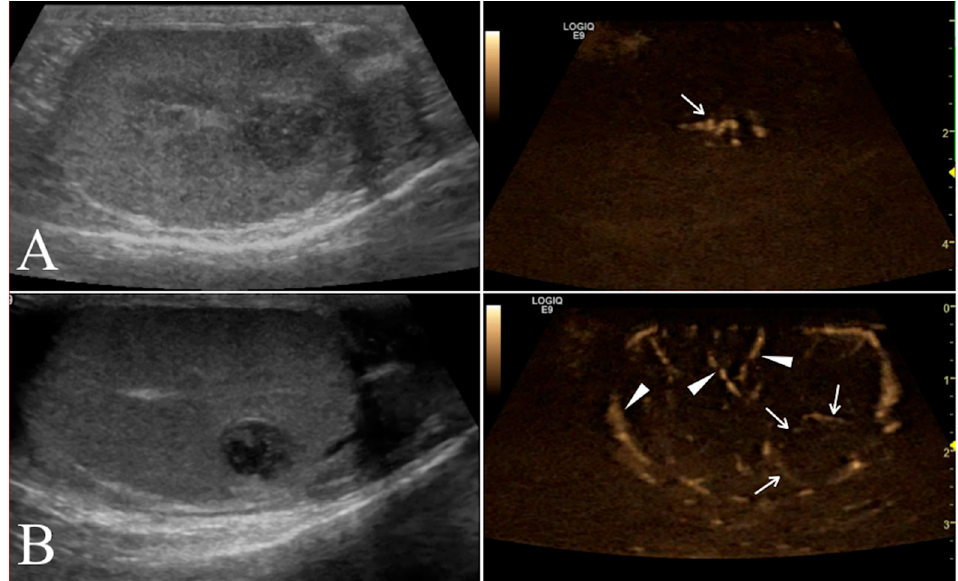
Figure 3. Conventional ultrasonographic scans (left panels) of two different seminomas found respectively in the right testicle of a 10 year old Labrador Retriever in ( A ) and in the right testicle of a 9.5 year old German shepherd in ( B ). In the right panel the B-flow images show the I distribution of the lesional vessels (arrow) scored as 2 in ( A ), while in ( B ) it was possible to record the P pattern of vessels distribution (arrows) scored in this case as 1. In this B-flow image, it is also possible to visualize some physiological testicular vessels (arrows head) , represented by the marginal region and intra-testicular branches of testicular artery.